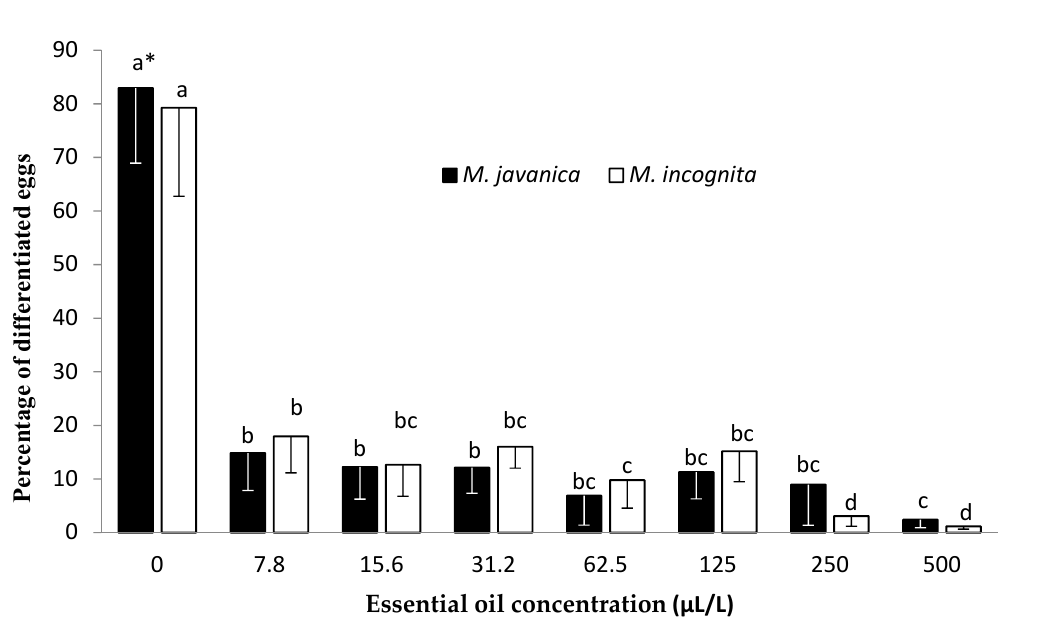
Plants 2021 , 10 , x FOR PEER REVIEW Figure 3. Effect of Cuminum cyminum seed essential oil on the differentiation of M. incognita and M. javanica eggs after immersion in test solutions at concentrations of 0, 7.8, 15.6, 31.2, 62.5, 125, 250, and 500 µ L/L for 28 days. * Bars with the same color followed by the same letter are not significantly different according to Tukey’s HSD test at p < 0.05.